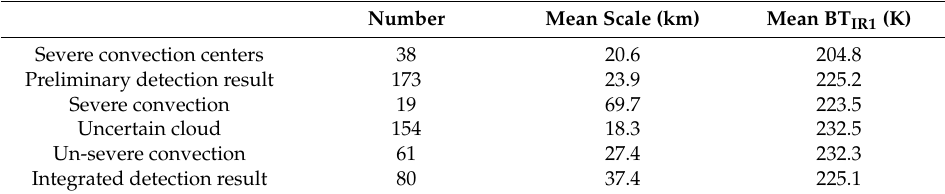
Table 2. Cloud statistical result of each step